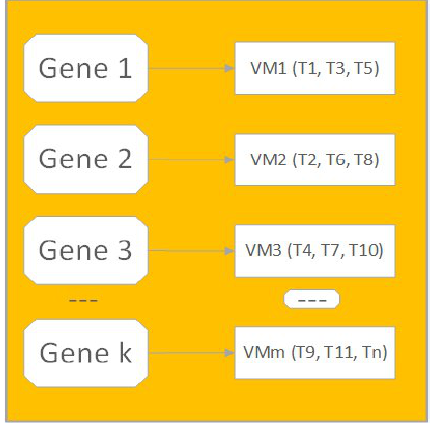
Figure 3. Representation of tasks and